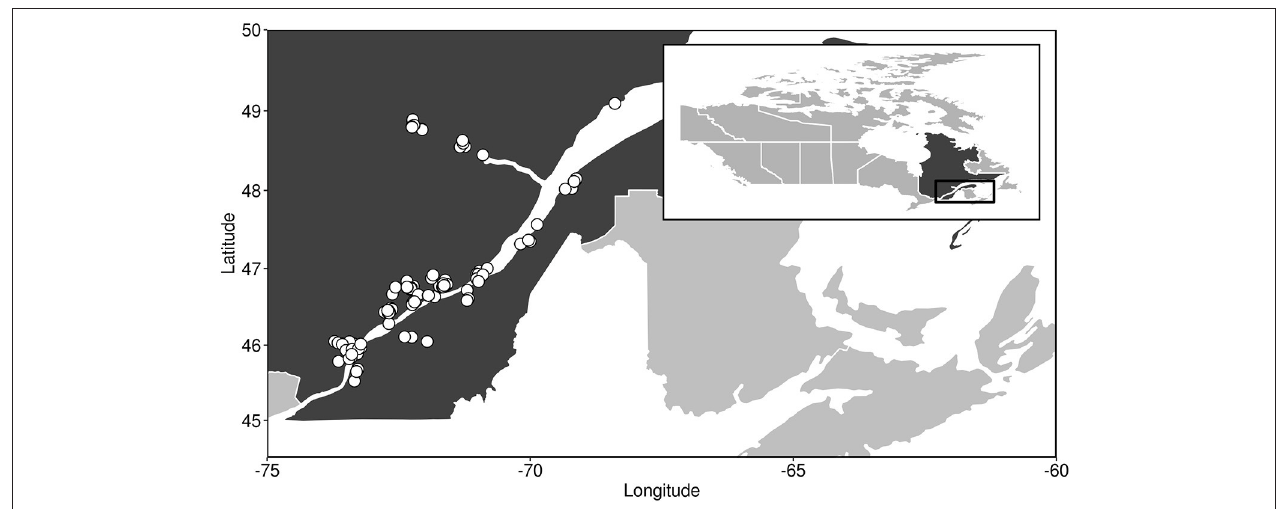
FIGURE 2 | Location of experimental sites in the Québec potato data